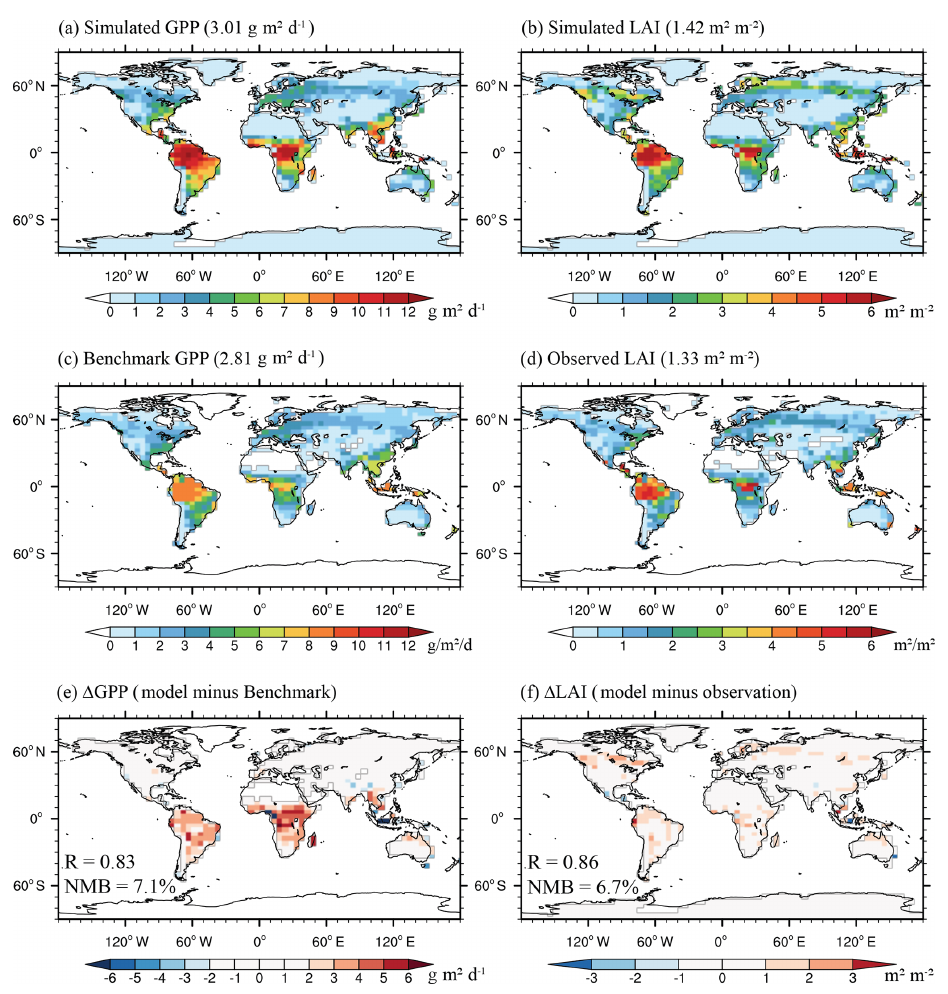
Figure 2. Annual gross primary productivity (GPP) and leaf area index (LAI) from offline simulations (a, b) , observations (c, d) , and their differences (e, f) averaged for the period of 2010–2012. Global area-weighted GPP and LAI are shown in parentheses in the panel captions. The correlation coefficients ( R ) and global normalized mean biases (NMBs) are shown in the bottom panels.